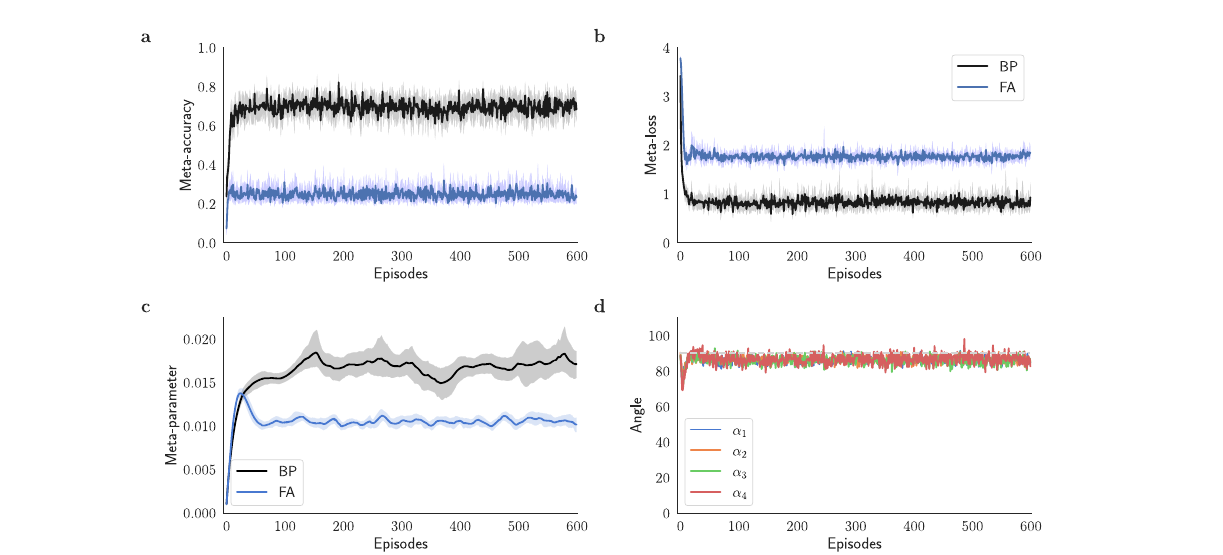
Fig. 3 | Meta-learning plasticity coef fi cients for feedback alignment and back- prop. a Meta-accuracy of feedback alignment (FA) compared to backprop (BP) trained using the meta-learning framework (Alg. 1) during 600 meta-optimization episodes and b the corresponding meta-loss. The lower accuracy of FA compared to BP in each episode manifests slower learning of FA when presented with the same number of training examples and steps as BP for a 5-way classi fi cation task.